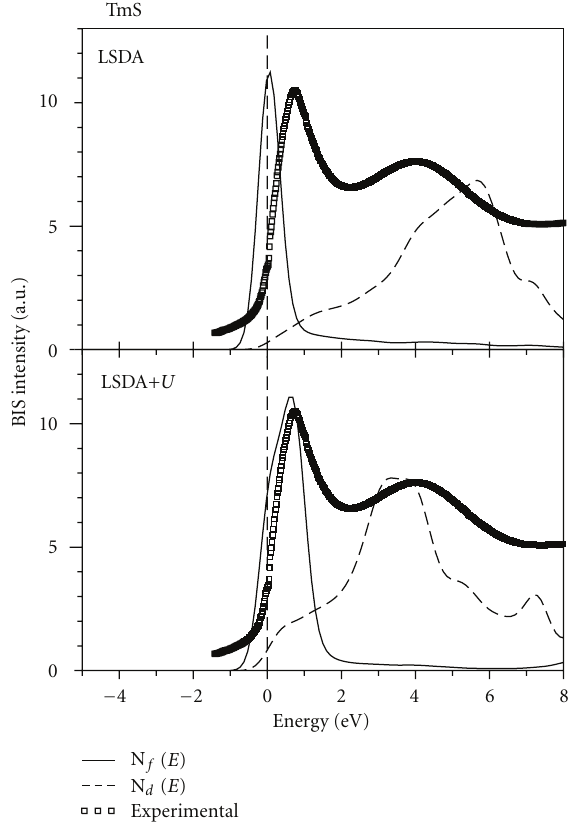
Figure 63: Comparison of the calculated partial 4 f (N f ( E )) and 5 d (N d ( E )) DOS in the LSDA and LSDA+ U approximations [384] with the experimental BIS spectrum of TmS from